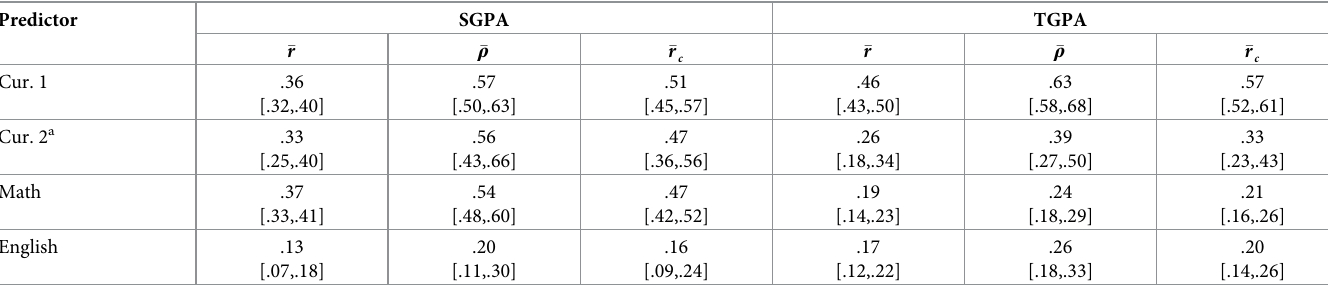
Table 4. Predictive validity for specific course achievement in the first